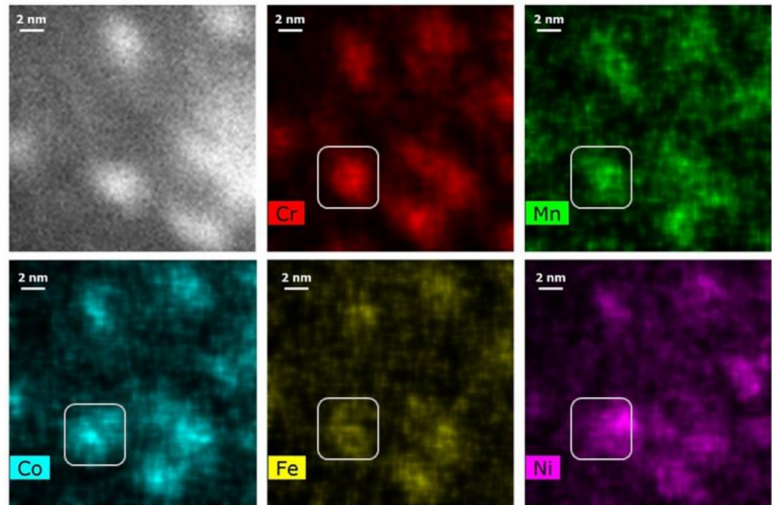
Figure 4. Chemical composition analysis of Cr-Mn-Fe-Co-Ni NPs transferred from the NPs IL suspension onto a carbon-coated gold grid and crystallized with the electron beam. The STEM-EDS maps show the presence and homogeneous distribution of Cr, Mn, Fe, Co, and Ni in each NP. For determination of the atomic composition of single NPs, specific areas were chosen as shown exemplary with a grey